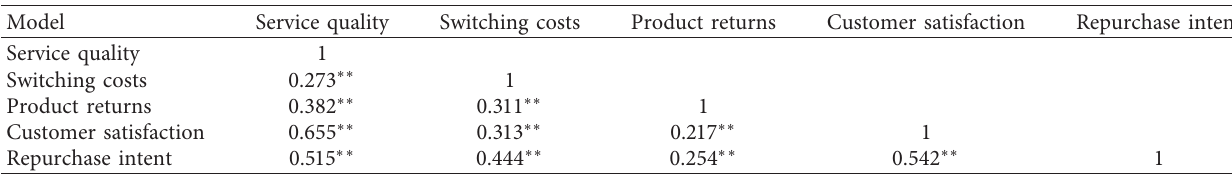
Table 9: Pearson’s correlation matrix.